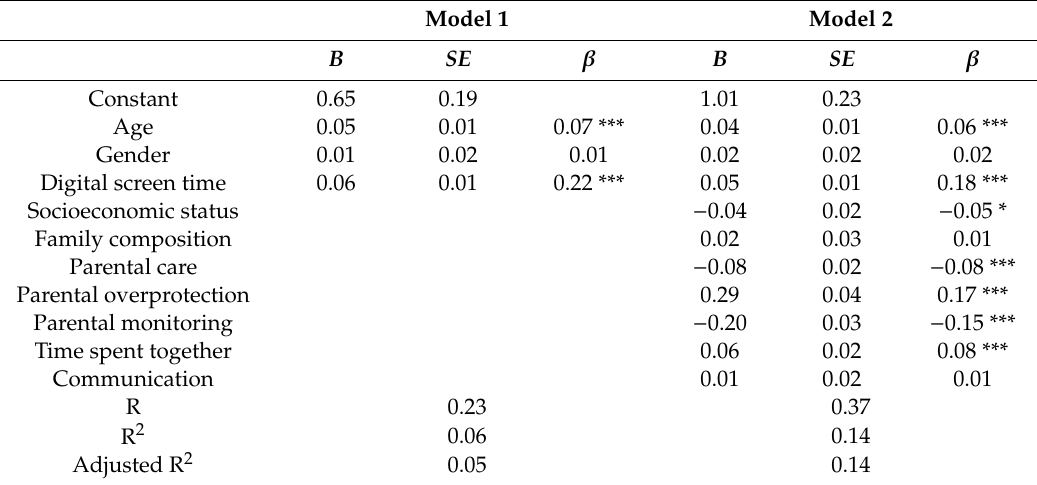
Table 3. Regression coe ffi